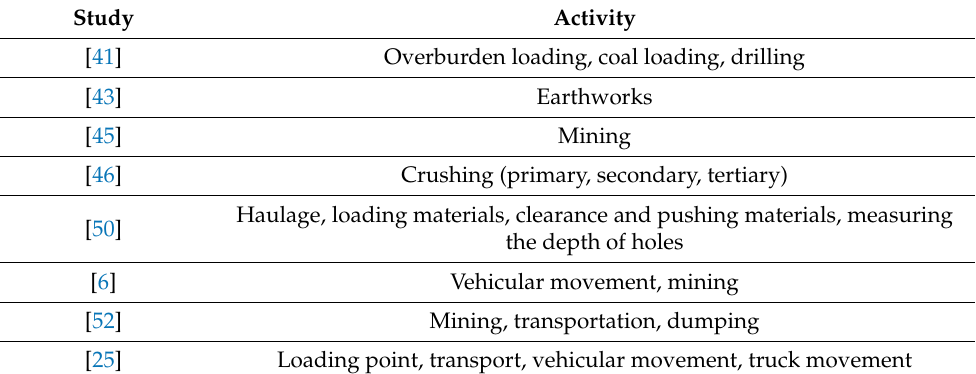
Table 2. Activity per